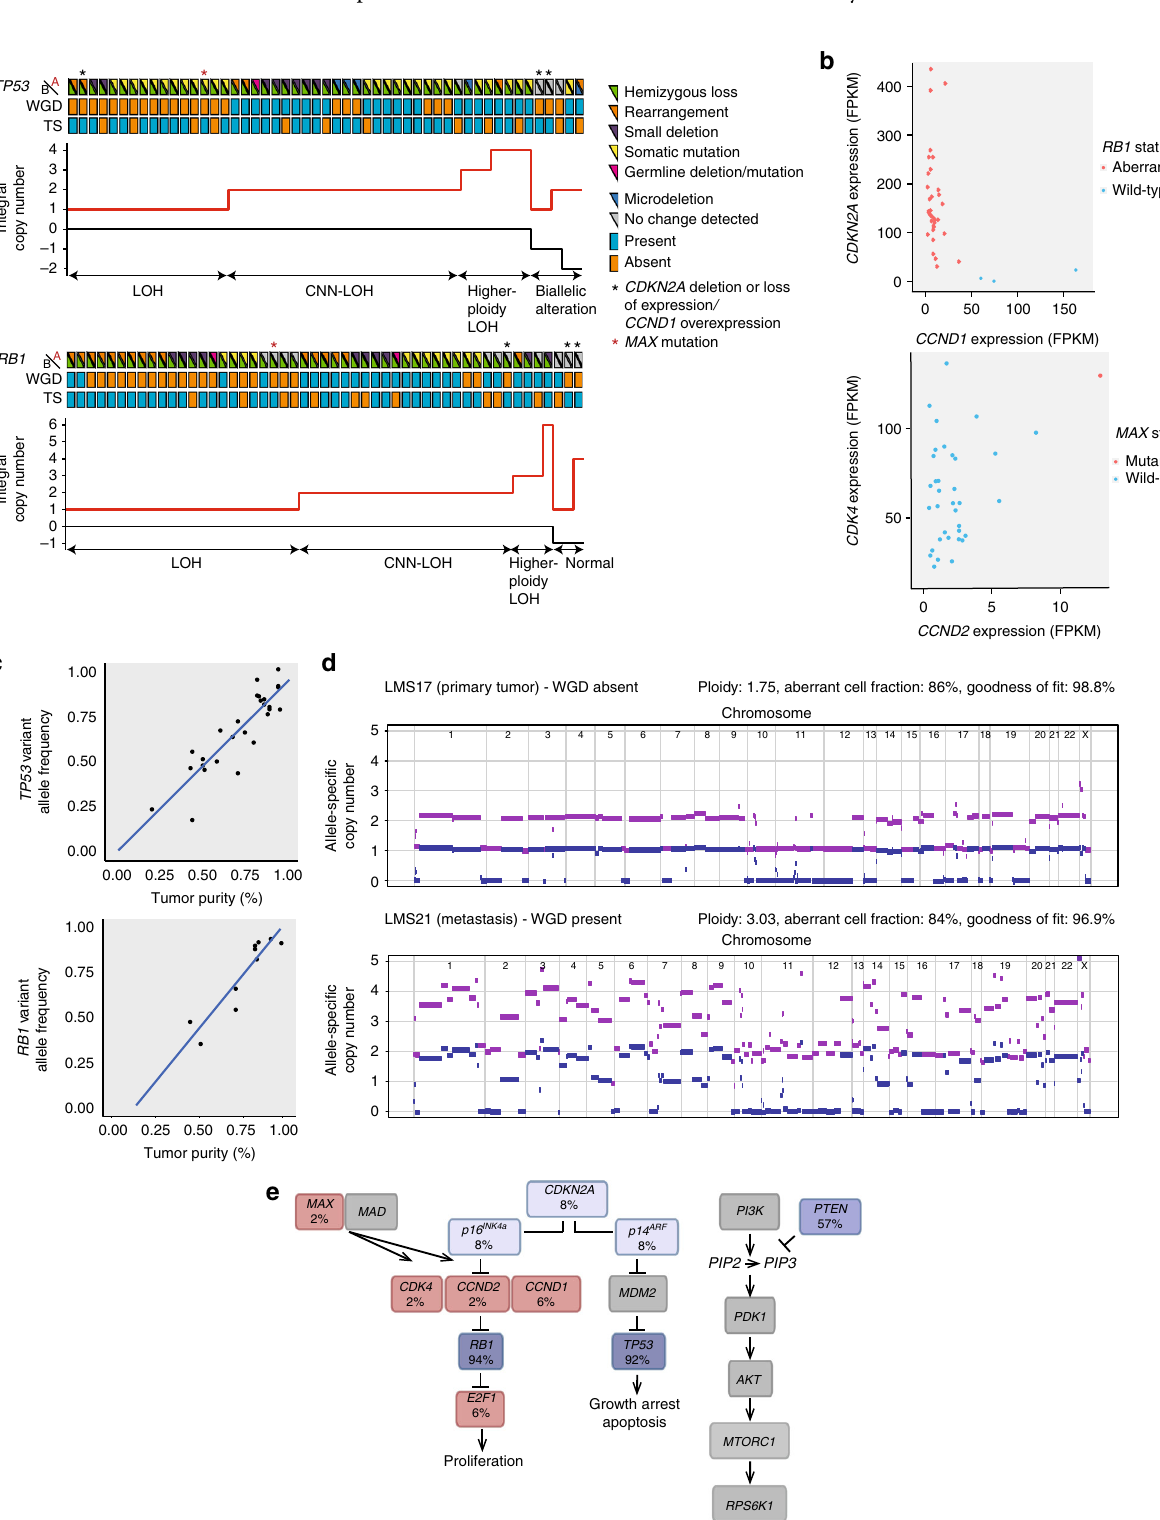
Ploidy: 3.03, aberrant cell fraction: 84%, goodness of